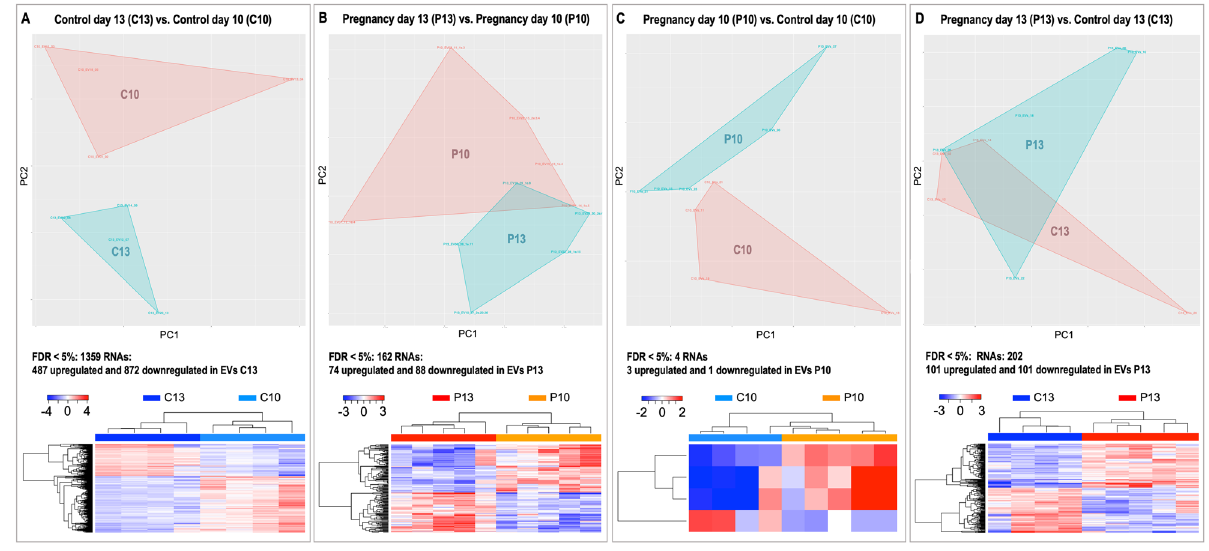
Figure 3. Comparative differential analysis of RNAs in uterine EVs. For each comparison, principal component analysis (PCA) and unsupervised hierarchical clustering (HCL) are shown, for: ( A ) cyclic control day 13 (C13) vs. control day 10 (C10); ( B ) pregnancy day 13 (P13) vs. pregnancy day 10 (P10); ( C ) pregnancy day 10 (P10) vs. control day 10 (C10); ( D ) pregnancy day 13 (P13) vs. control day 13 (C13). For each HCL, rows indicate differential RNAs, while columns represent individual samples collected from pregnant and cyclic mares, respectively. Mean-centered expression values (log2 of counts per million of respective sample – mean of all samples) are shown. Color scale in blue shows lower than mean and in red higher than mean. PCA and HCL images created with Bioconductor package EdgeR (https:// bioco nduct or. org/ packa ges/ relea se/ bioc/ html/ edgeR. html) 91 and other standard R packages and modified with Adobe Photoshop v.22.4.3. Labelling of each sample refers to: day of pregnancy or cycle; followed by the number of EV sample from 1 to 24; followed by the number of endometrial sample collected at the same time and analyzed in a parallel study 56 ; followed by the embryo size (e.g., 1e.5: one embryo collected with 5 mm diameter; 2e.3.4 = two embryos were collected with 3 and 4 mm; nd: the diameter could not be determined, embryo broken during collection; 0: for control